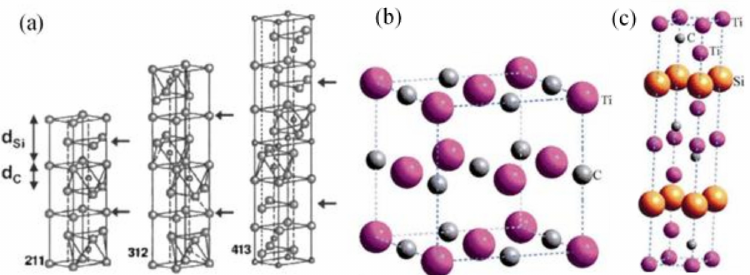
Figure 6. Crystal structure of MAX phases from different sources: ( a ) M n + 1 AX n phase structures for n = 1, 2 and 3 [28]; ( b ) TiC crystal structure [26]; ( c ) Ti 3 SiC 2 crystal structure [26].